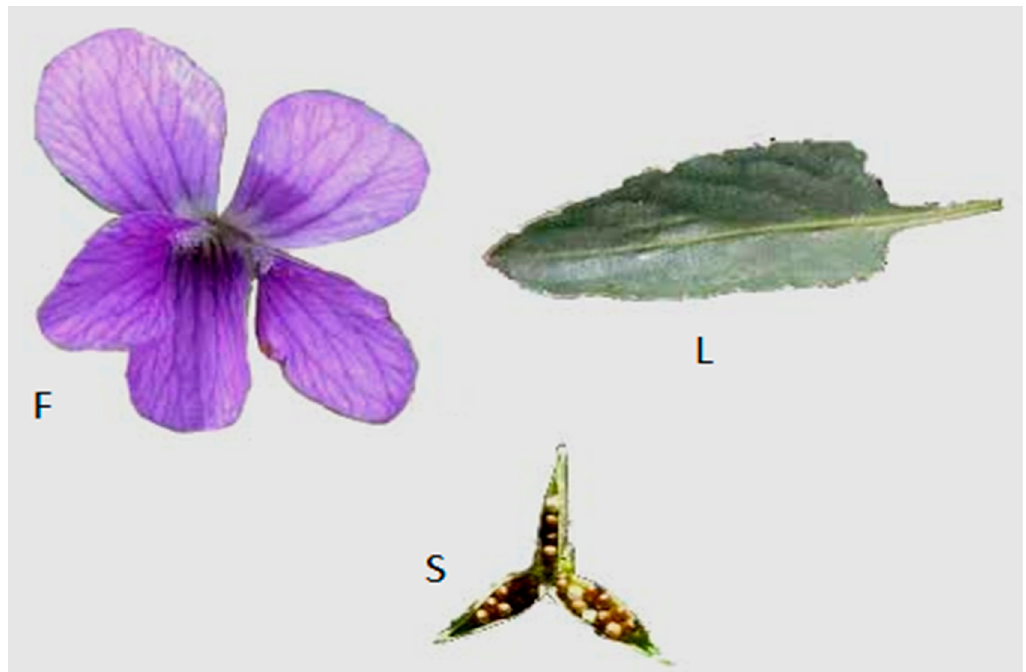
Figure 1. Different parts of plant V. betonicifolia : L., leaf; F., flower; S, seed. Figure 1. Di ff erent parts of plant V. betonicifolia : L., leaf; F., flower; S,